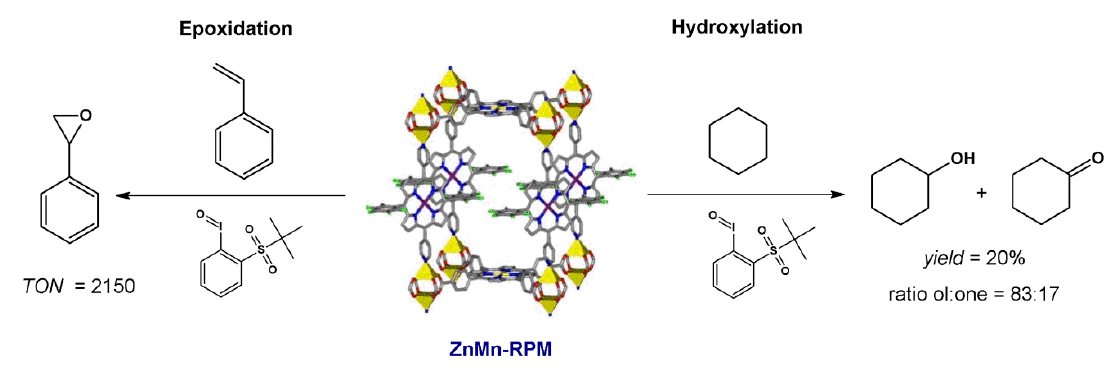
Figure 7. Epoxidation of styrene (left) and hydroxylation of cyclohexane (right) by an iodosylbenzene derivative, catalyzed by ZnMn-RPM. Reprinted (adapted) with permission from [108]. Copyright (2011) American Chemical Society.